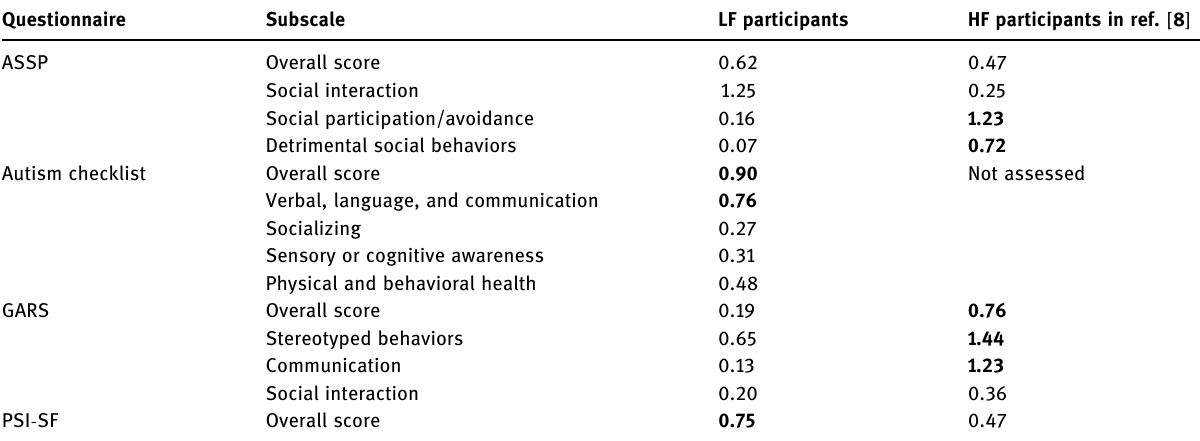
Table 4: Cohen ’ s d e ff ect size between the Pre - Test and Post - Test scores of the questionnaires ( the results of ref. [ 8 ] are also presented in the table for comparison of the impacts of the program on LF and HF subjects ) Questionnaire